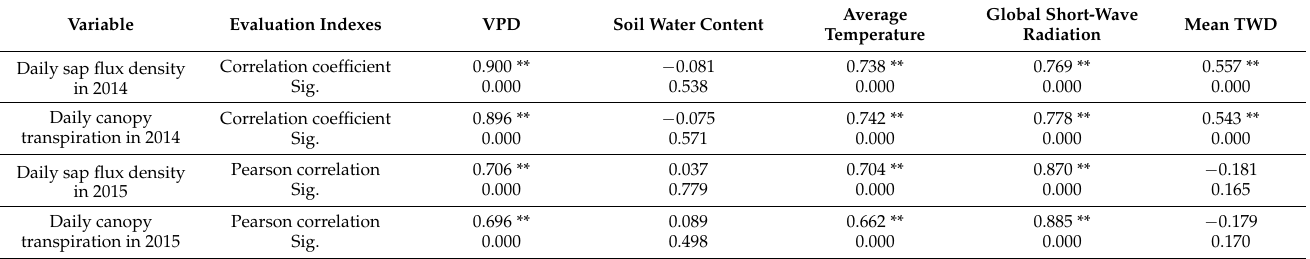
Figure 4. Daily sap flux density and canopy transpiration rates during the growing season for treatment and control groups (daily mean and standard deviations), and box plots of values averaged for the season. Table 3. Spearman’s rho correlations between the sap flux density, canopy transpiration, and environ- mental